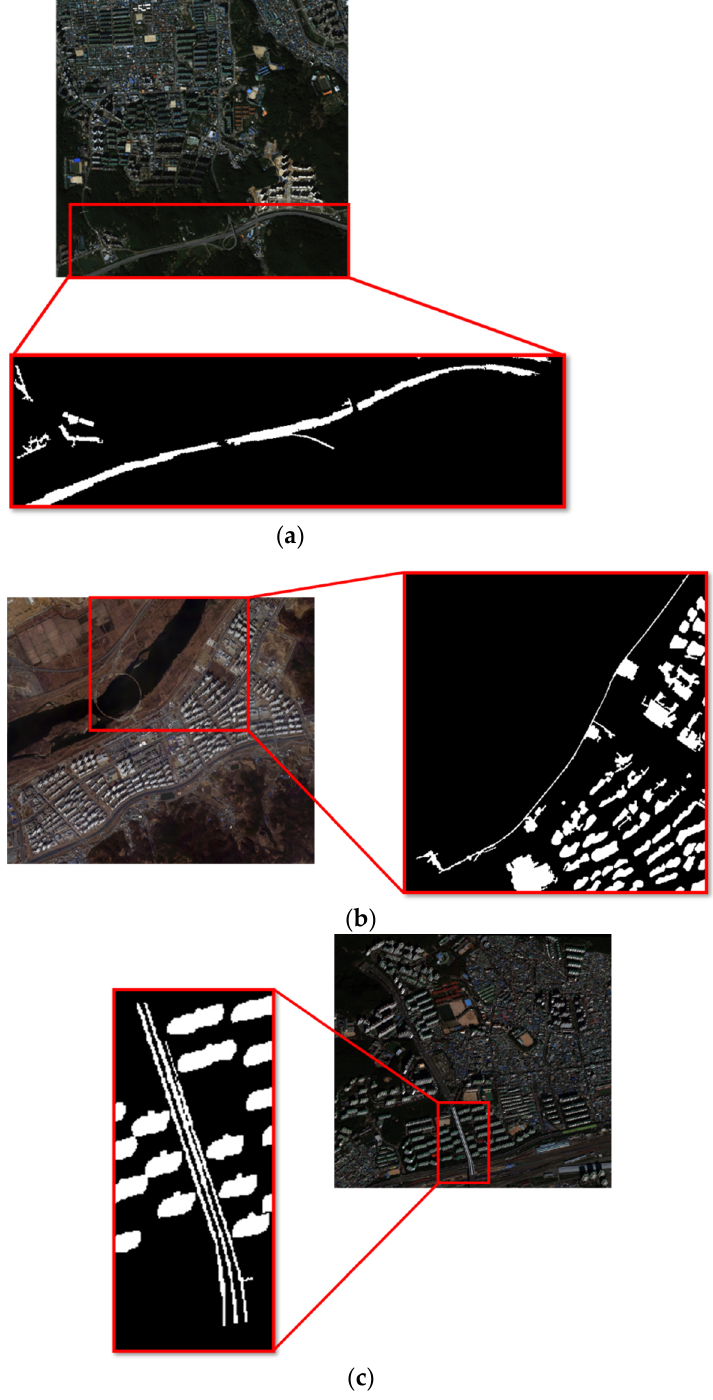
Figure 12. The roads that were misdetected by the morphological building index as buildings: ( a ) Site 1; ( b ) Site 2; ( c ) Site 3 imagery.